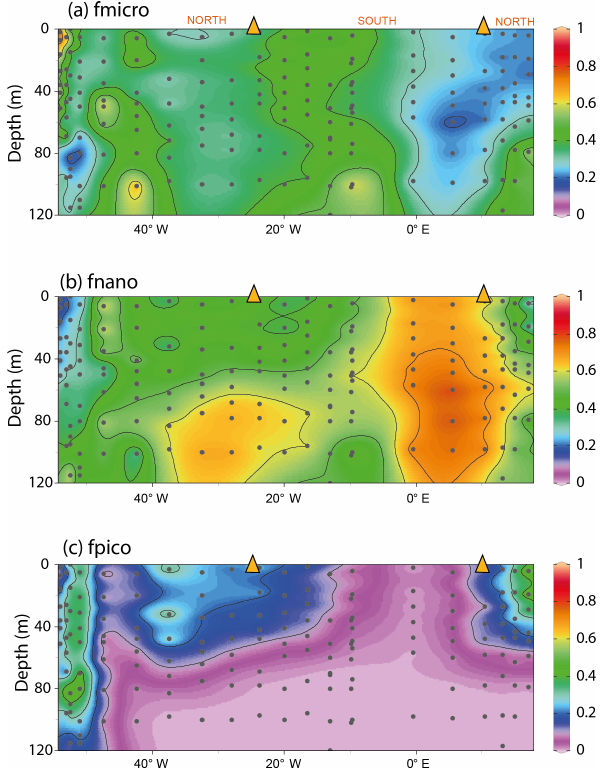
Figure 4. The fractional contribution of phytoplankton size classes to total chlorophyll as estimated from phytoplankton pigments. The size classes are defined as pico ( < 2µm), nano (2–20µm) and micro (20–200µm). “f” signifies the fractional contribution to the chloro- phyll a concentration. Size class estimates were calculated follow- ing (Uitz et al., 2008). The interpolation was produced using ODV- weighted average gridding (Schlitzer, 2018).